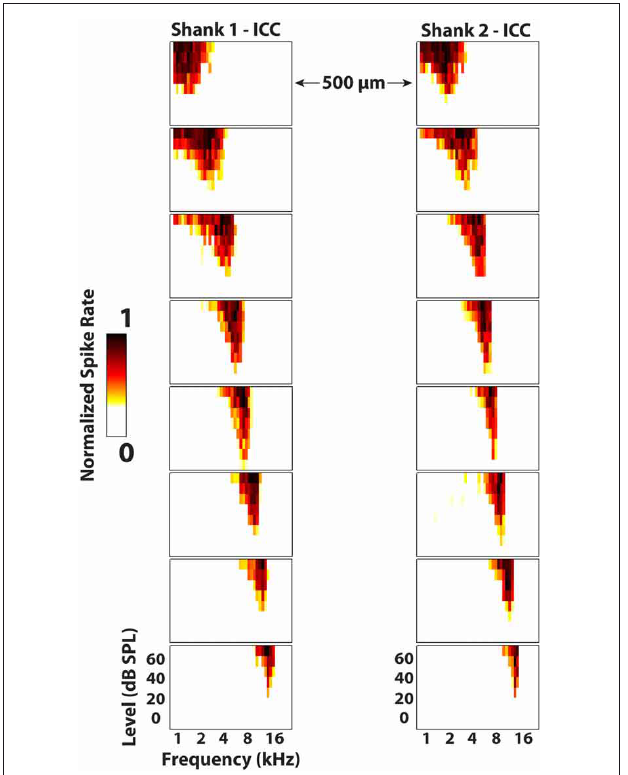
FIGURE 8 | Frequency response maps for two electrode shanks separated by 500 µ m placed in the central nucleus of the inferior colliculus (ICC). ICC placements are characterized by sharp tuning and a consistent tonotopic shift from low (superficial sites) to high (deep sites) frequencies. Spike rates were normalized to the maximum number of spikes for each site across all stimuli. Every other site (200 μ m spacing) along the electrode shank is plotted. The colorbar was adjusted to remove spontaneous activity to enhance visualization of the response